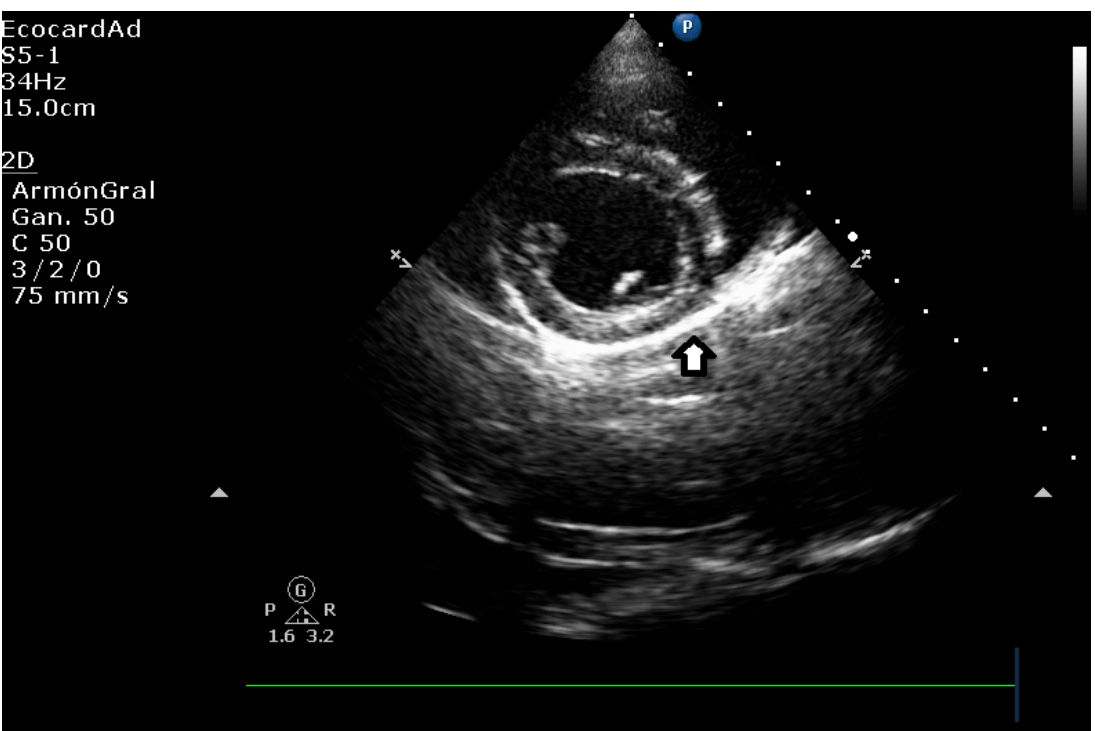
Figure 2. Right parasternal short axis view in the canine patient, showing pericardium as a hyperechoic line surrounding myocardium.